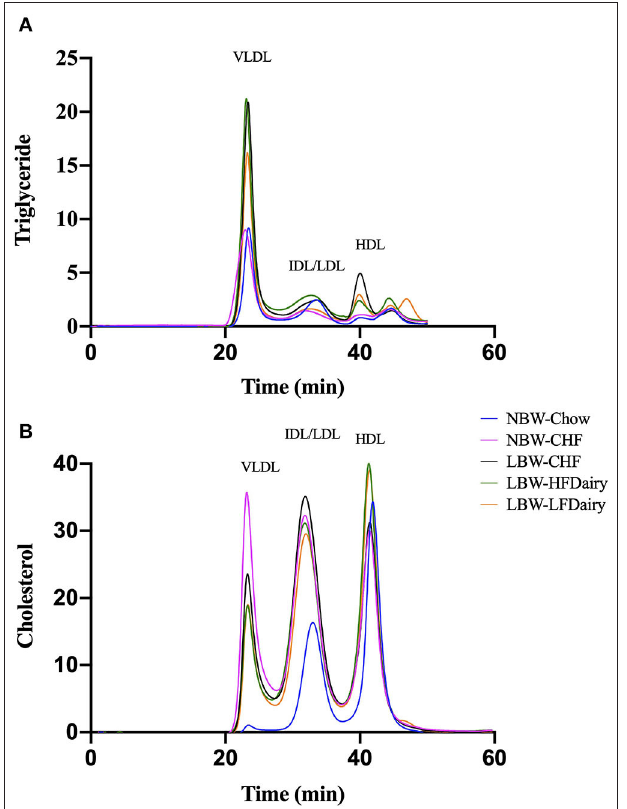
FIGURE 3 | Fasting plasma triglyceride (A) and cholesterol (B) in lipoprotein subfractions measured by FPLC. CHF, control high-fat diet; FPLC, fast protein liquid chromatography; HDL, high-density lipoprotein; HFDairy, high-fat dairy diet; IDL, intermediate-density lipoprotein; LBW, low birthweight; LDL, low-density lipoprotein; LFDairy, low-fat dairy diet; NBW, normal birthweight; VLDL, very low-density lipoprotein.